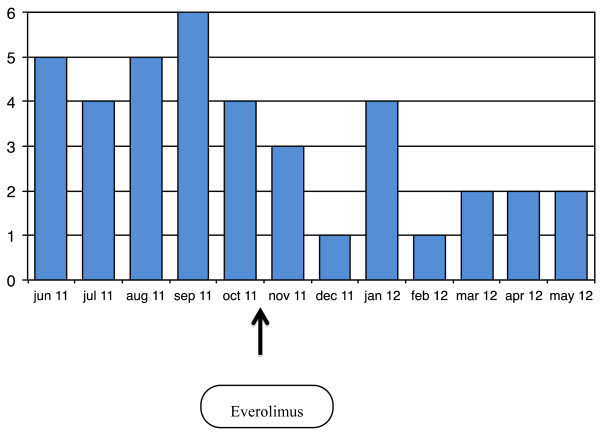
Monthly seizure frequency in a TSC girl. A girl with a TSC2 mutation presented refractory seizures since the age of 7 years. When she was 20 years old she presented mainly secondarily generalized tonic and tonic-clonic seizures. The image shows her seizure frequency per month before and during Everolimus treatment. With everolimus seizure frequency decreased, generalized seizures stopped, and she continued to have only focal onset seizures of short duration, without drop attacks nor falling to the ground.